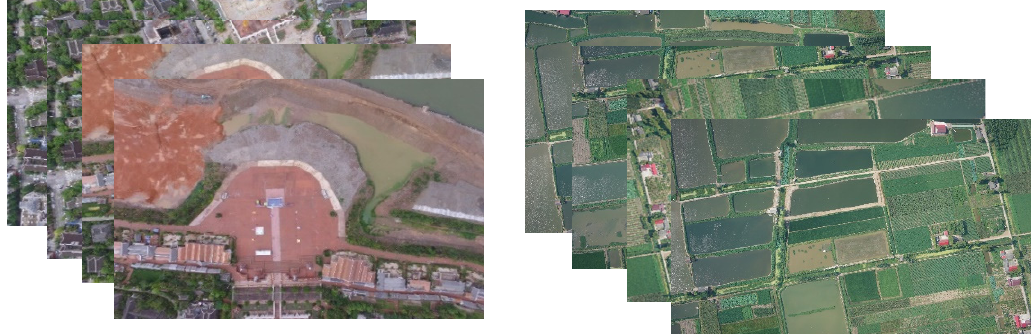
Figure 3. Two image sequences, (only four of which are shown here. The left one is data set 1. The right one is data set